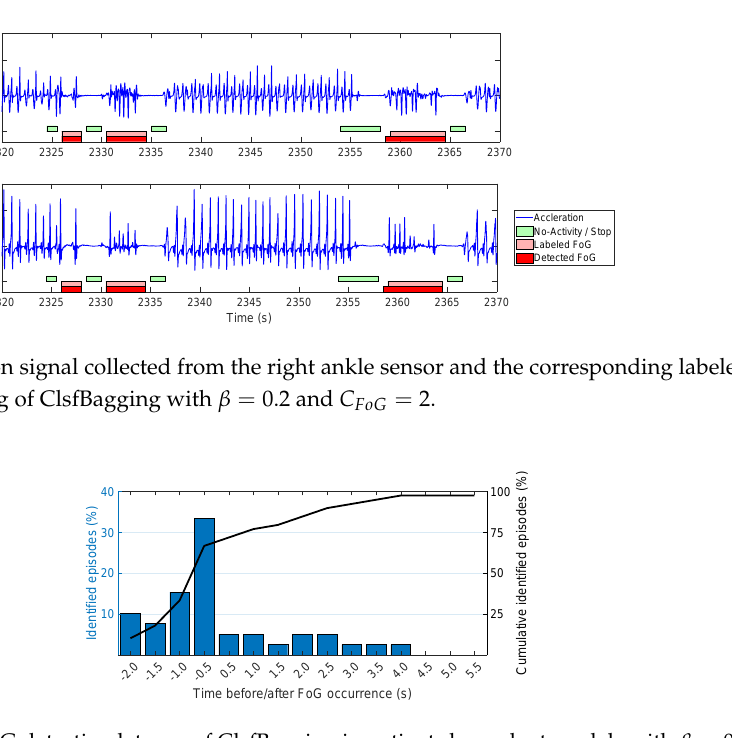
Figure 6. Average FoG detection latency of ClsfBagging in patient-dependent models with β = 0.2 and C FoG = 2. Negative values of time represent duration before FoG